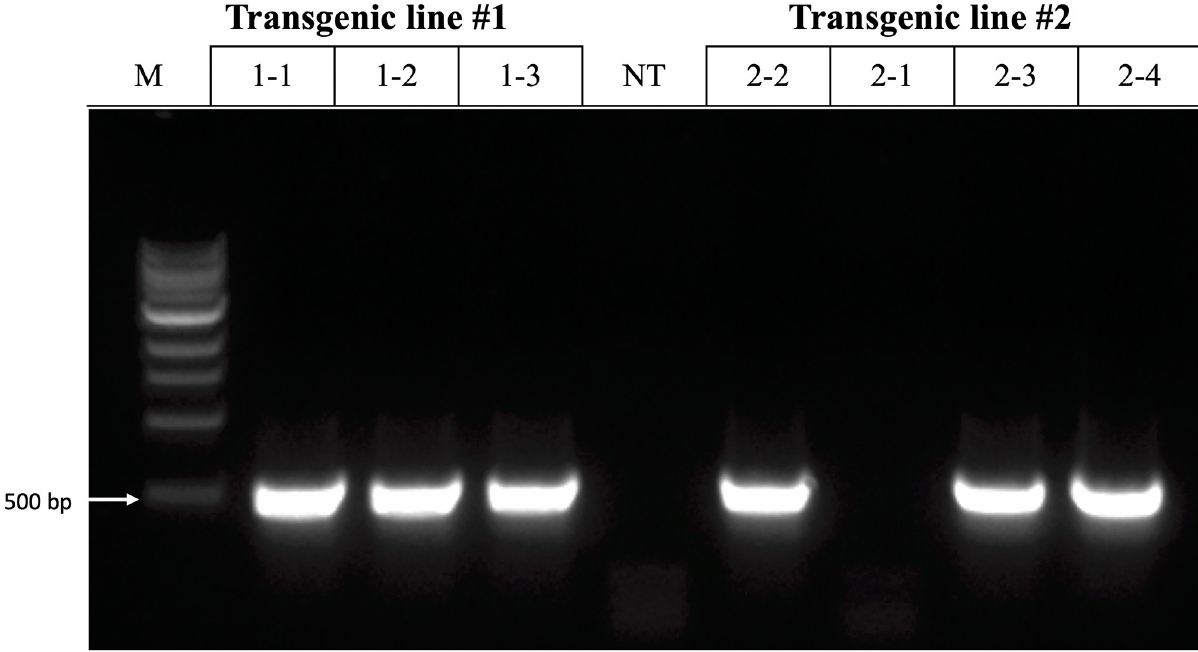
Fig 6. RT-PCR analysis of bar expression in leaves of T 1 transgenic and nontransgenic (NT) plants of ‘Olathe’ pinto bean. M: size ladder.